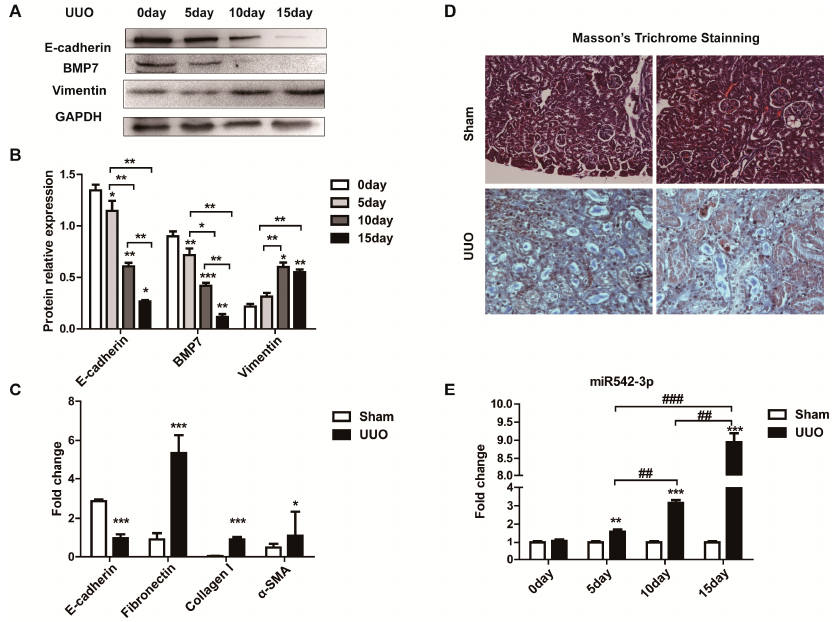
Figure 1. MiR542-3p up-regulation in the unilateral ureteral obstruction (UUO) mice model. ( A ) Compared with control groups, the E-cadherin and BMP7 proteins were reduced in the UUO kidney; ( B ) Histogram showed the gray scale quantitative analysis for Western blot, * p < 0.05, ** p < 0.01, *** p < 0.001; ( C ) The change of expression levels of Epithelial-Eesenchymal Transition (EMT) and fibrotic marker’s mRNA levels, * p < 0.05, *** p < 0.001, mRNAs expression were normalized to 18sRNA; ( D ) Masson’s Trichrome staining; ( E ) The miR542-3p expression levels was elevated in kidney of UUO mice model, ** p < 0.01, *** p < 0.001, ## p < 0.01, ### p < 0.001 the miR542-3p expression was normalized to U6. All data are presented as means ± SD from three independent experiments.